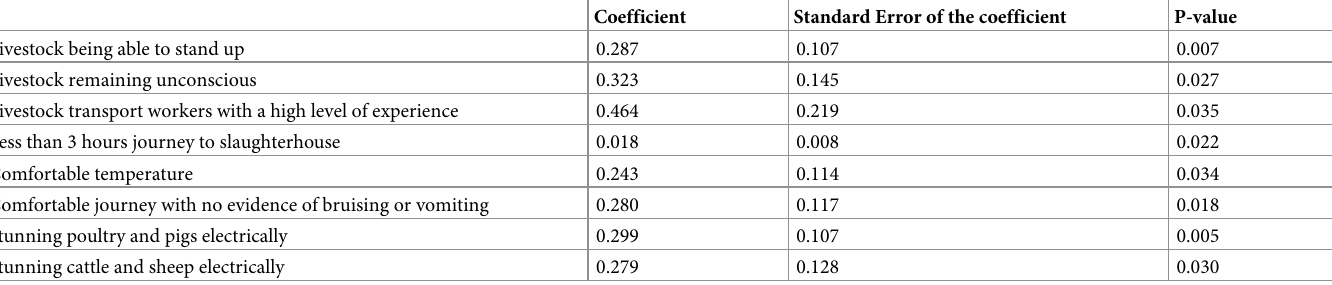
Table 3. Effects of the knowledge of respondents (n = 267), who were stakeholders in the animal transportation and slaughter sectors, about transport on their ascribed utility values, which measure the perceived importance of different issues for animal welfare, when the relationship was examined by linear regression in a general linear model. The relationship is reported as a regression coefficient, SE coefficient and probability (P) value of the regression being